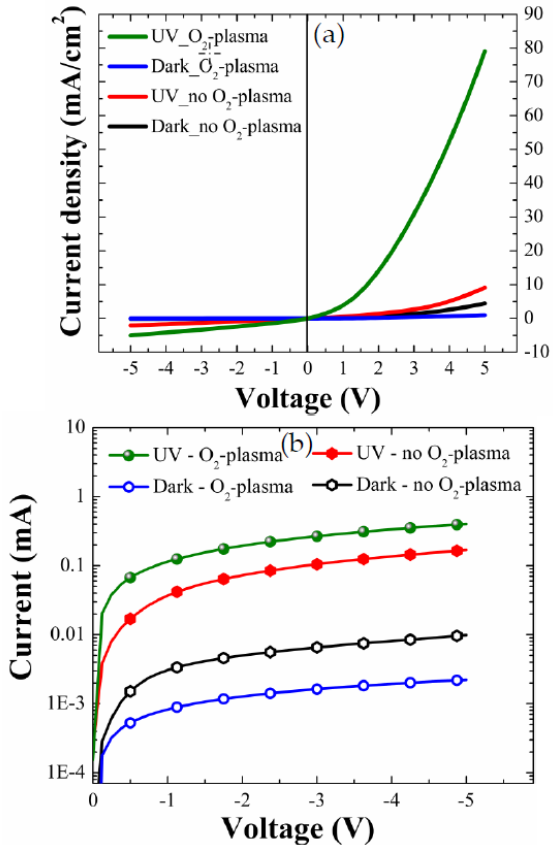
Figure 7. ( a ) Typical diode I–V characteristics in linear scale and ( b ) reverse bias characteristics in log scale, of p-Si/n-ZnO NRs grown on as-coated and O 2 -plasma-treated (for 9 min) SLs under dark and UV illumination conditions.